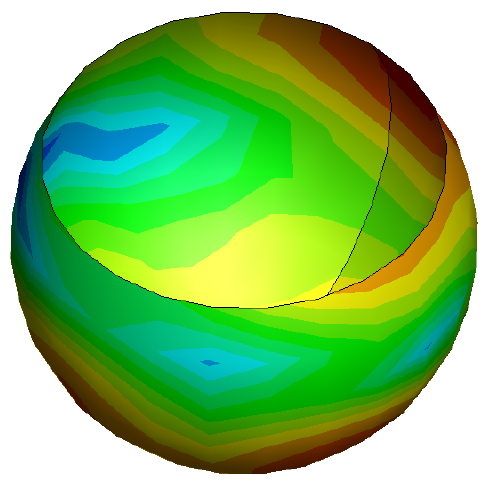
Figure 7: Three-dimensional representation of OASPL evaluated on the hemisphere surface by Technique A at point 1 in maneuver ID8021.